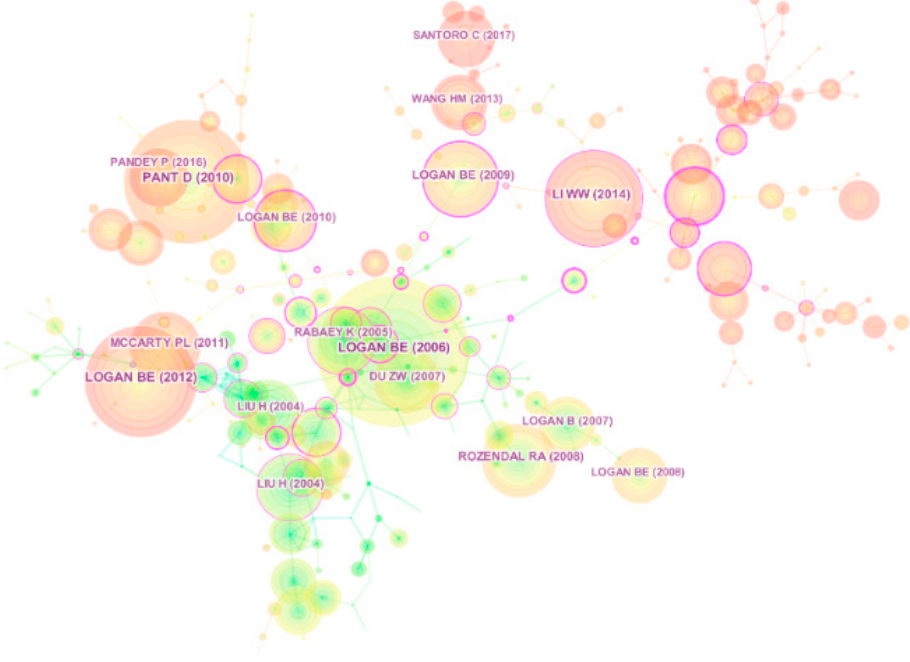
Figure 4. Full shot of document co-citation network.